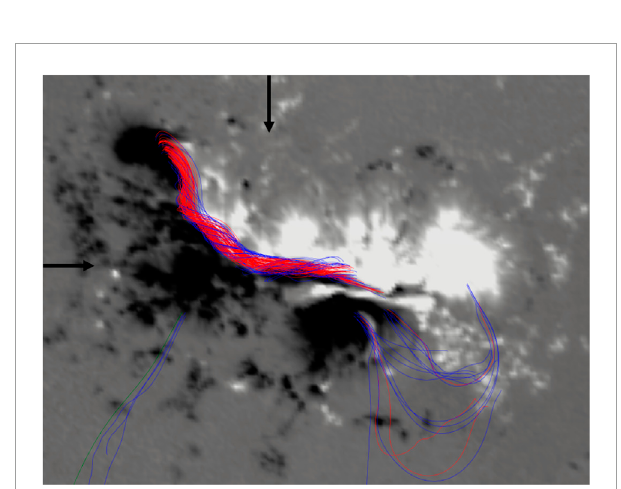
FIGURE 6 The 00:00UT OR data volume plotted over the 00:00UT magnetogram. Blue lines indicate closed field lines with 1.5 ≤| T w | < 2.0, red lines indicate closed field lines with | T w | ≥ 2.0, and green lines indicate open field lines. Note that the open field lines are lines that extend out of the [400,200,200] box and do not necessarily open to interplanetary space. The arrows at the top and on the side represent the center lines of the xz-plane and yz-plane views, respectively, seen in Figure 7